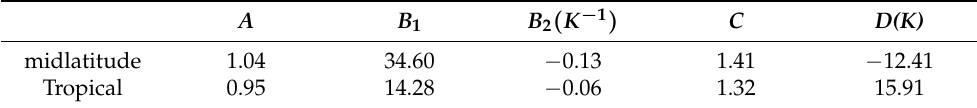
Table 3. Calculated